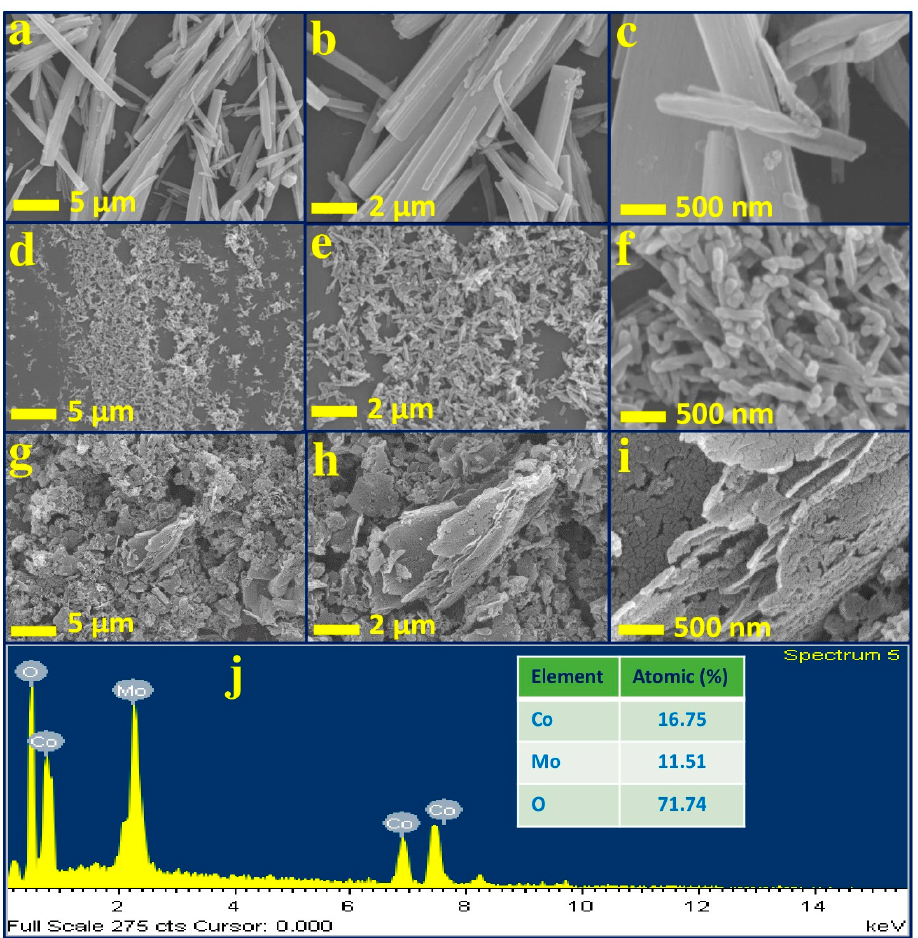
Figure 2. Low- and high-magnification SEM images of R-CMO ( a – c ), B-CMO ( d – f ), S-CMO ( g – i ) and EDS spectrum of R-CMO ( j ).